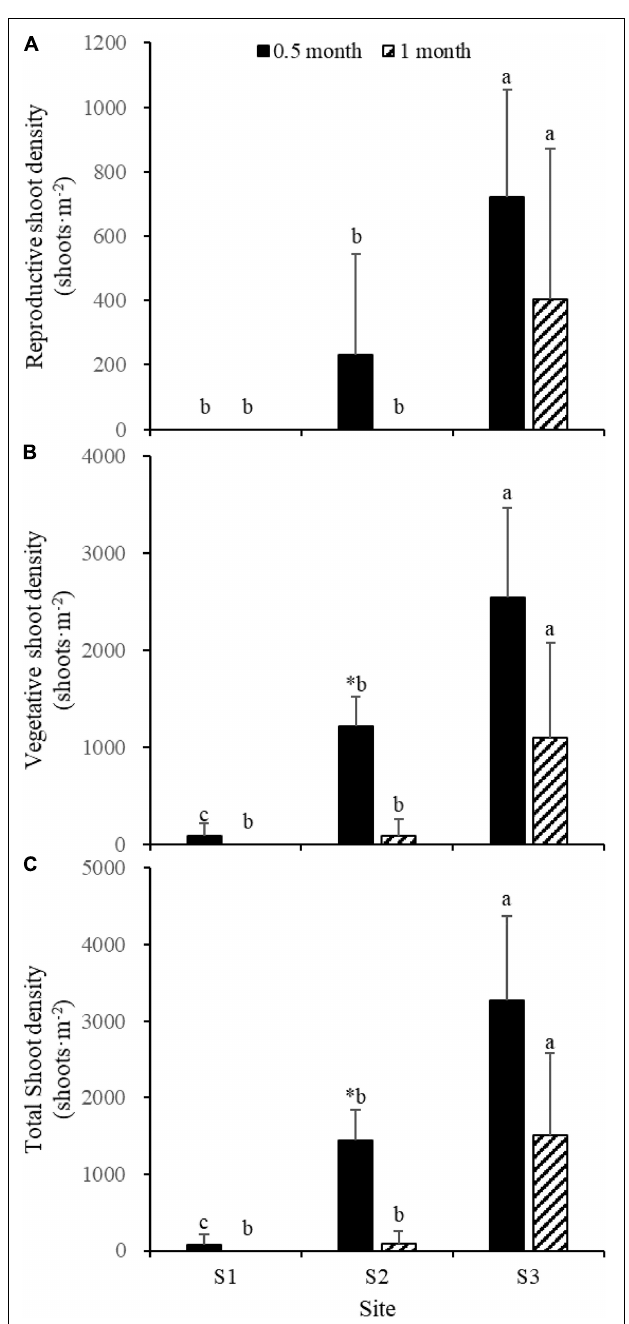
FIGURE 8 | Reproductive shoot density (A) , vegetative shoot density (B) , and total shoot density (C) of Zostera japonica in the three transplant sites at 0.5 and 1 month after transplantation. Values are mean ± SD. ∗ Indicates significant difference between different time points in the same transplant site. Different letters indicate significant difference between different transplant sites at the same time